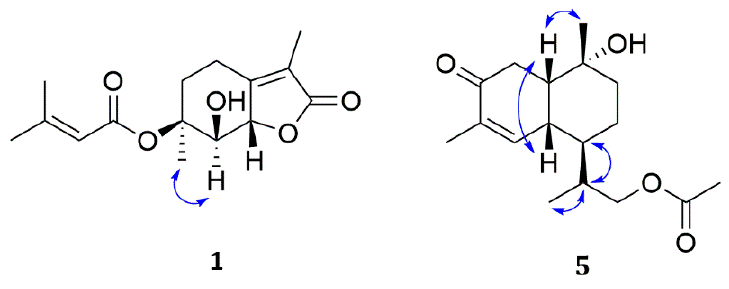
Figure 3. Key NOESY correlations of compounds 1 and 5 . Compound 2 was obtained as a white powder with the molecular formula of C 15 H 22 O 5 , in agreement with the positive HRESIMS ion peak at m/z 305.1387 [M + Na] + (calcd for C 15 H 22 O 5 Na 305.1359). An intensive comparison of its 1 H and 13 C spectra with those of 1 indicated that compound 2 was closely similar to 1 . The noticeable chemical shift differences as compared to 1 were detected for H-2 (cid:48) ( δ H 5.81 to δ H 2.33) with additional signals H-3 (cid:48) ( δ H 2.08) and for the corresponding carbons being shielded from δ C 115.1 to (cid:48) ) and δ (cid:48) ), which indicated that the double bonds at C-2 (cid:48) δ δ C 42.7 (C-2 C 158.5 to C 25.3 (C-3 and C-3 (cid:48) of compound 2 were reduced. The HMBC correlations from H-3 (cid:48) to C-2 (cid:48) , C-4 (cid:48) , spectrum were almost the same as those of 1 . Hence, the absolute configuration of 2 was